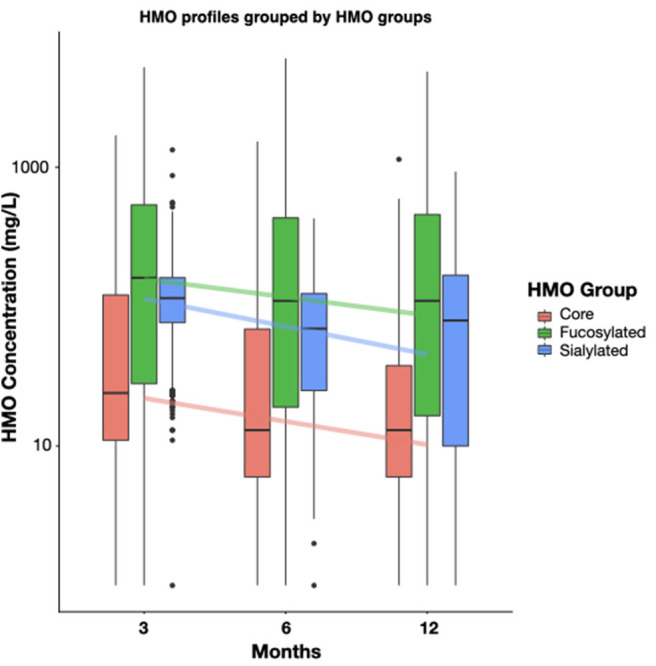
Dynamics of HMO concentration by the 3 main HMO classes, (i) core, (ii) fucosylated, and (iii) sialylated HMOs, between 3 and 12 months of lactation. The core class represents the sum of; LNT, LNnT, Hex4HexNAc2, LNH, 3′GL, 6′GL; The fucosylated class represents the sum of: A-tetra, 2′FL, LDFT, 3FL, LNFP-I, LNFP-II, LNFP-III, LNFP-V, LNnFP-V, LNnDFH,LNDFH-I, DFLNHa, MFLNH-III; The sialylated class represents the sum of: 3′SL, 6′SL, LSTb, LSTc, DSLNT. Boxplots depict median with interquartile ranges and whiskers indicate the minimum and maximum values. For all classes the 3 months to 6 months and the 6 months to 12 months changes were significant by non-parametric t-test (p < 0.05). Concentrations are shown as mg/L.